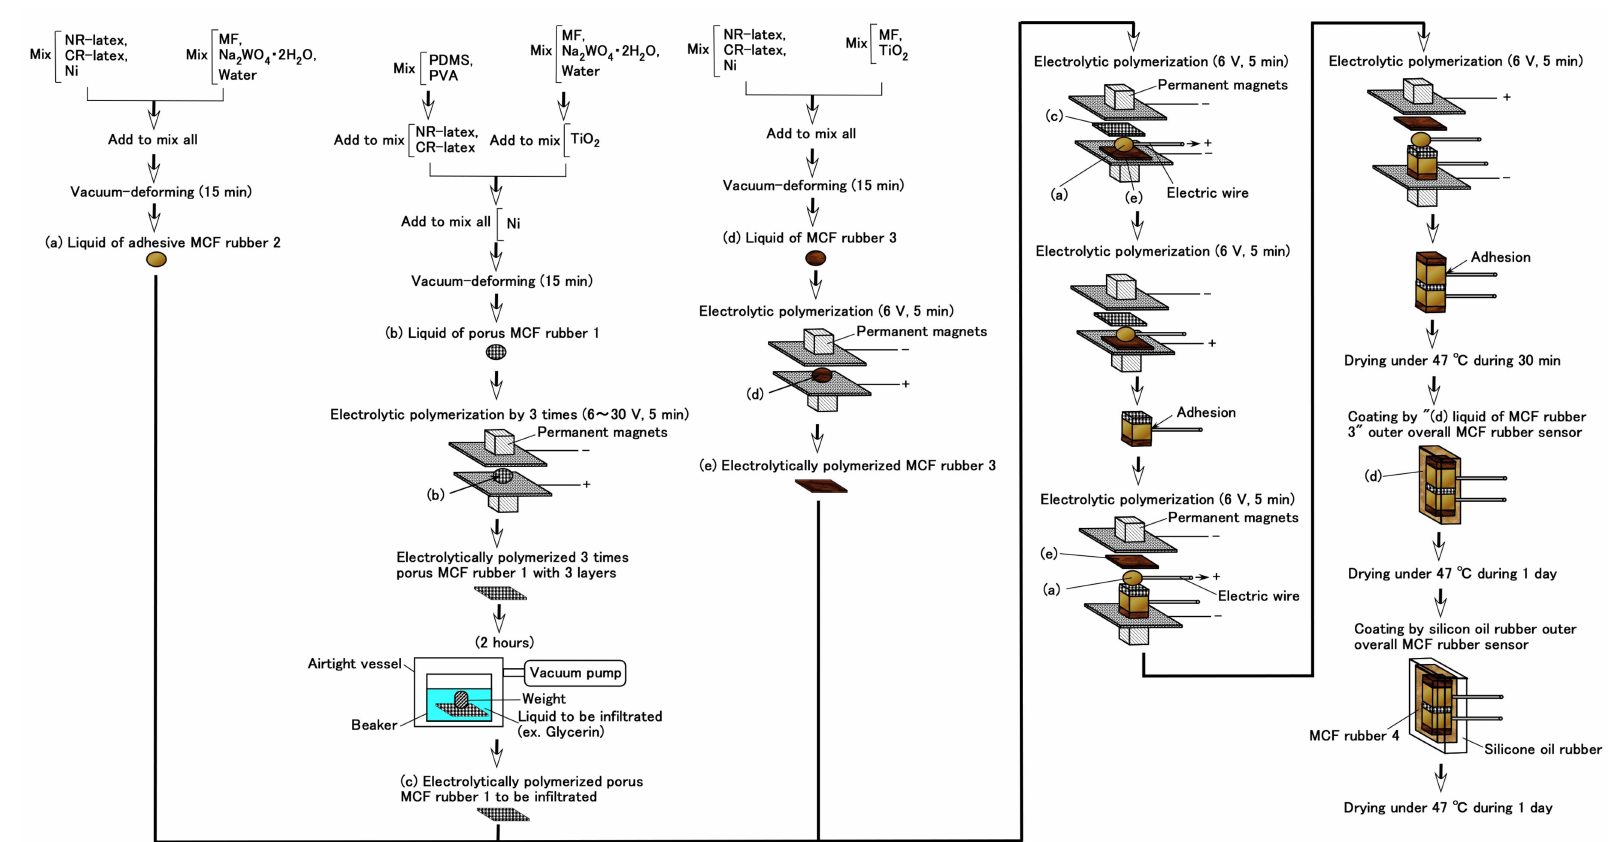
Figure 21. Production procedure of consummate fabrication of MCF rubber